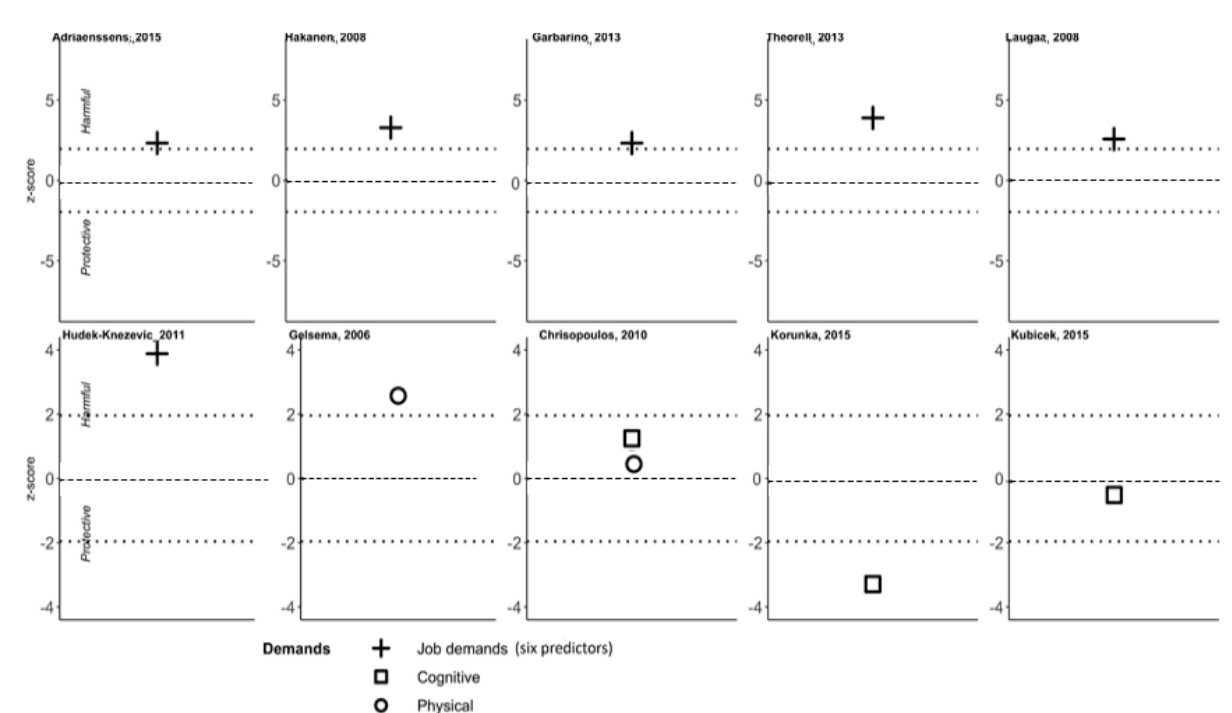
Figure 3. Description of predictor’s families and subfamilies.